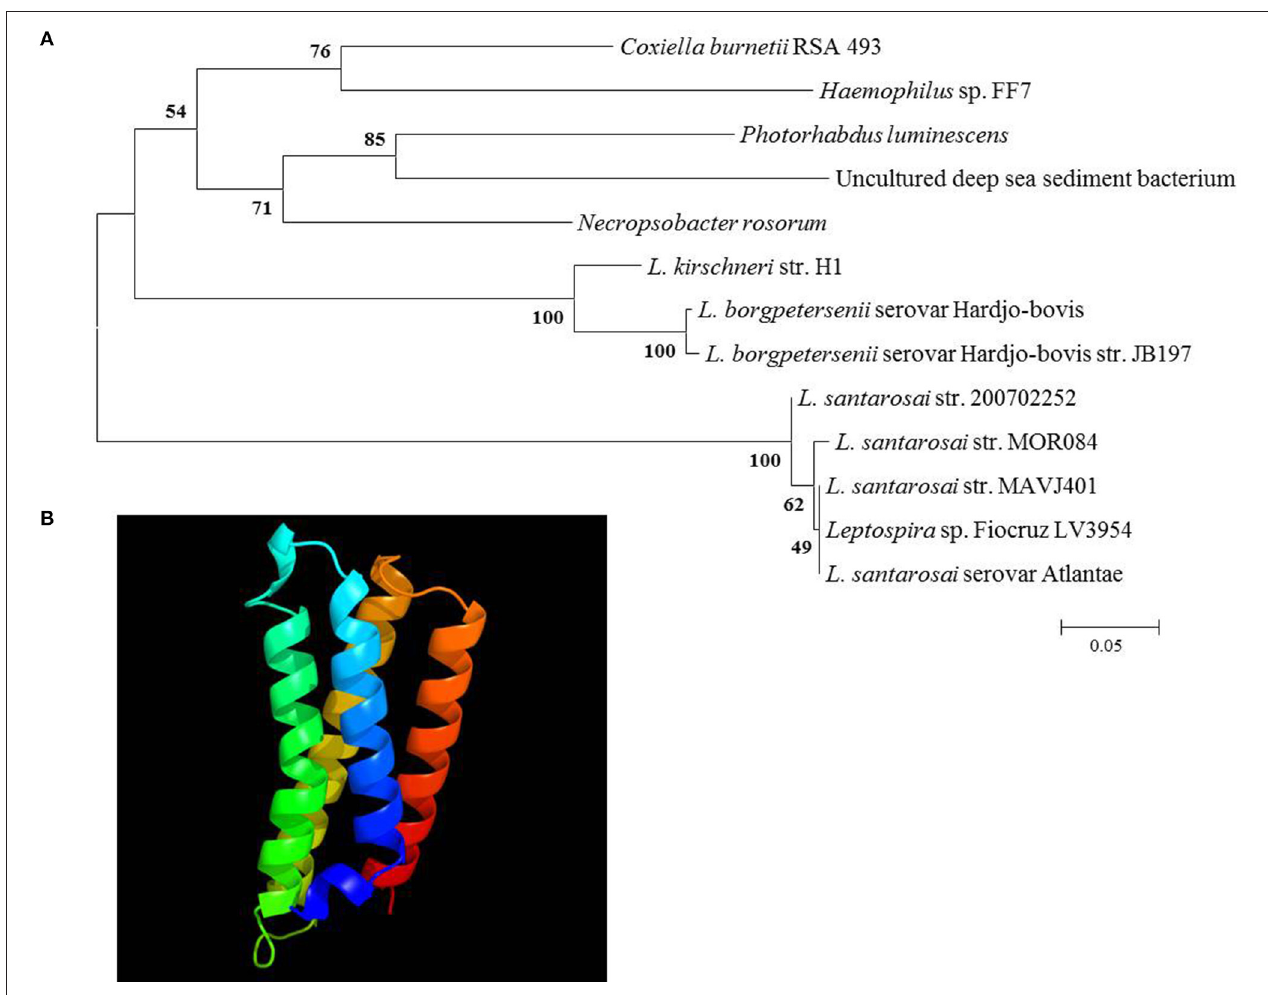
FIGURE 4 | Phylogenetic analysis and predicted secondary structure of the S23p. (A) A neighbor-joining tree from predicted amino acid sequences of IVS ORF-encoded S23p superfamily proteins of the top 12 BLASTp hits to C. burnetii ’s S23p. Bootstrap values (1000 replicates) are indicated at the nodes. Amino acid sequence identities ranged from 54 to 71% with C. burnetii ’s S23p ( L . = Leptospira ). (B) Secondary structure of C. burnetii ’s S23p as predicted by PHYRE2 (Kelley et al., 2015).